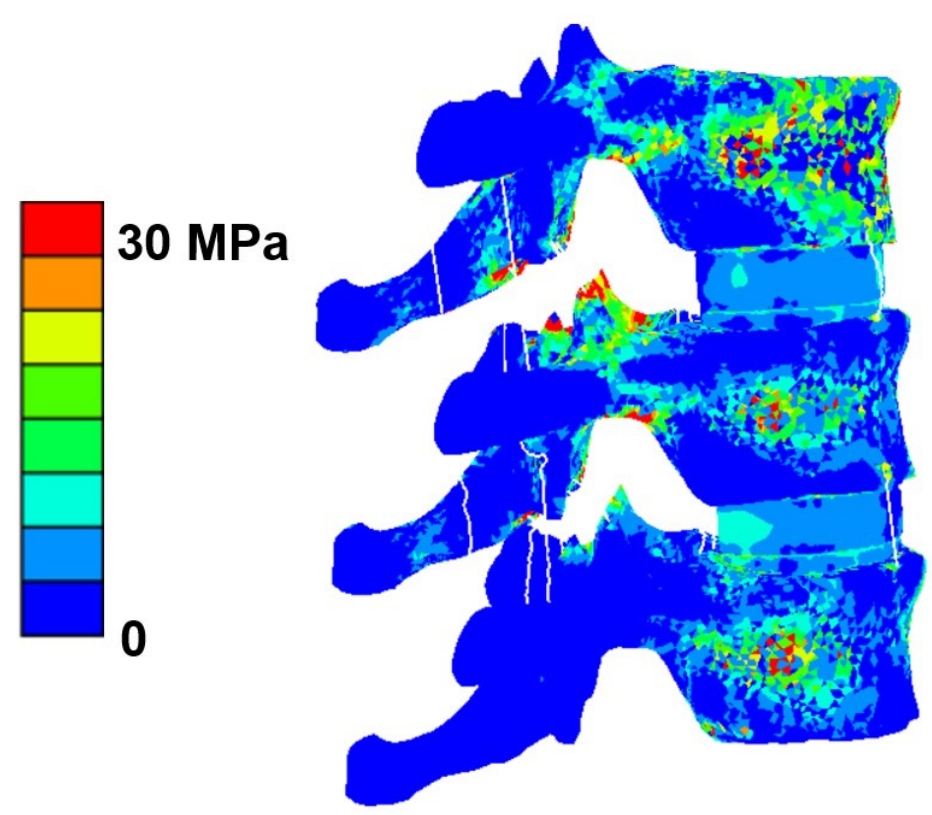
Figure 9. Von Mises stress distribution contour for the vertebrae and the disk for the FSU model at failure.